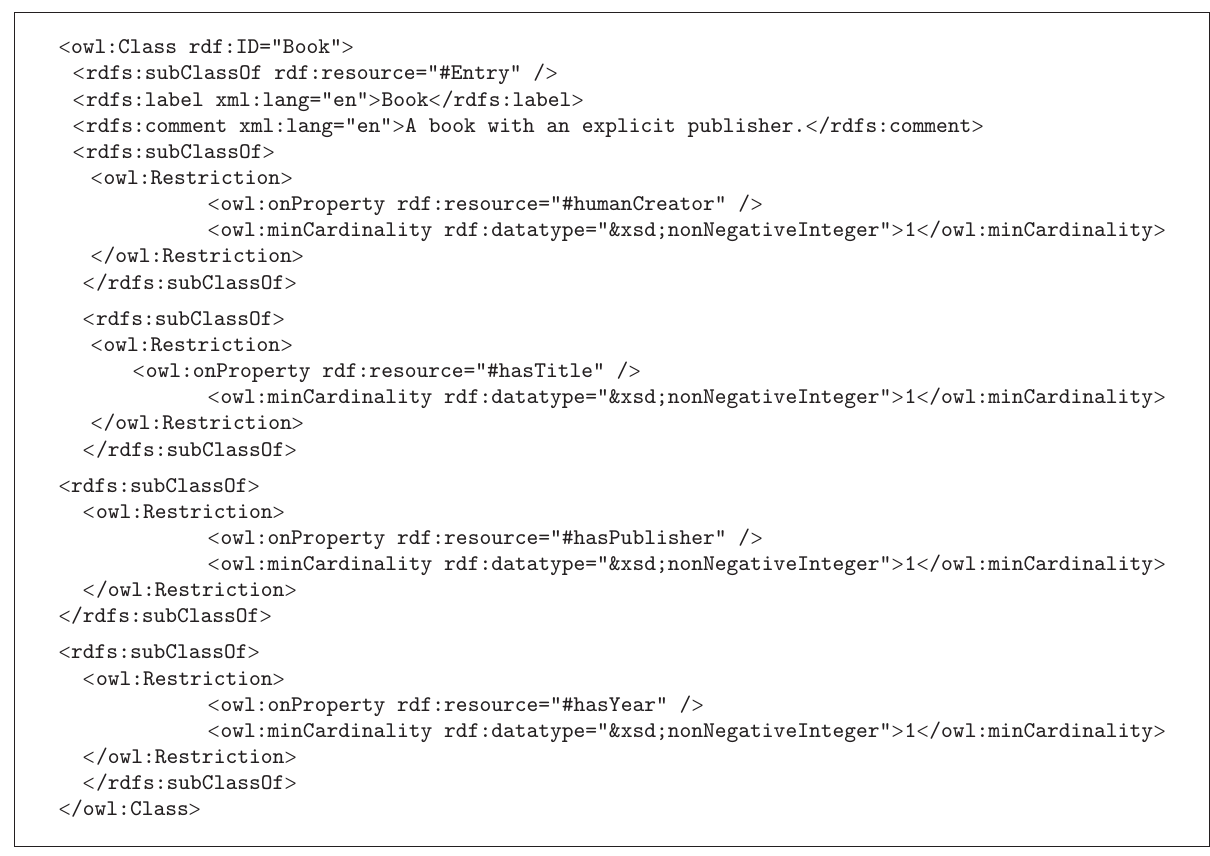
Algorithm 1: Bibtex OWL/XML ontology for